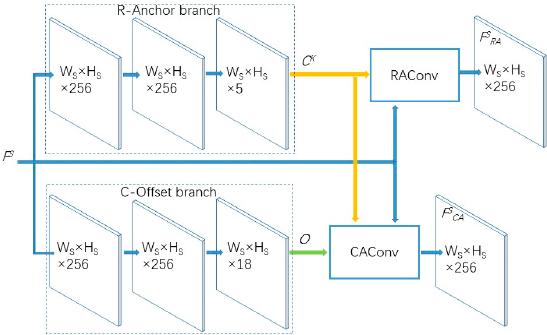
Figure 4. Overview of the DAM, which consists of two convolutional branches (R-Anchor branch and C-Offset branch) and two alignment convolutions (RAConv and CAConv). With the feature map ( F S ) of scale ( S ) as input, the R-Anchor branch produces the kernel coordinates ( C K ), and the C-Offset branch produces the sampling offsets ( O ). The W S × H S × Channel represents a feature map with the width of W s , the height of H s , and the channel of Channel extracted by convolution. With the kernel coordinates ( C K ) and the sampling offsets ( O ), the RAConv and CAConv produce the regression feature map ( F S ) and classification feature map ( F S ), RA CA